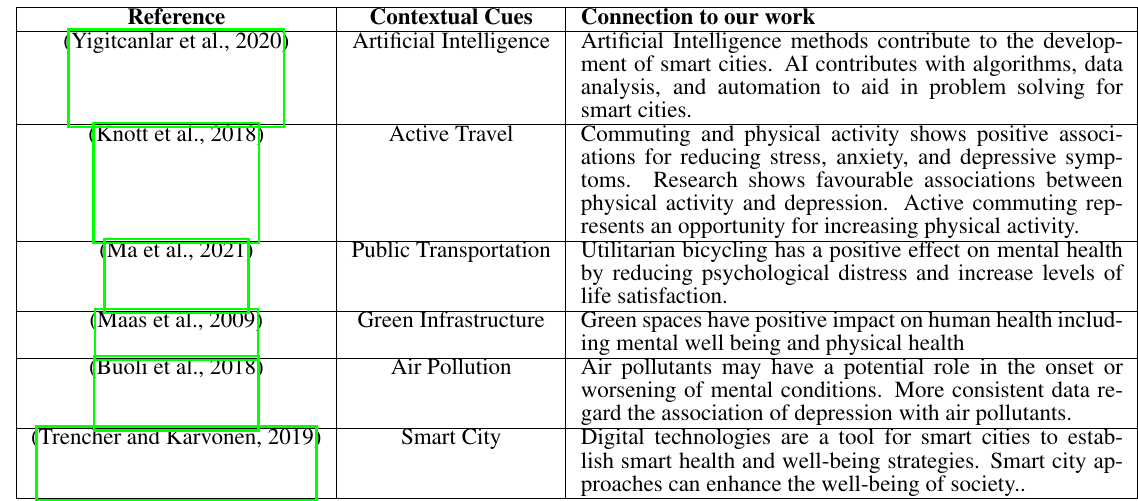
Table 1. A summary of related work. The contribution of the research to our work is described in the ’Connection to our work’